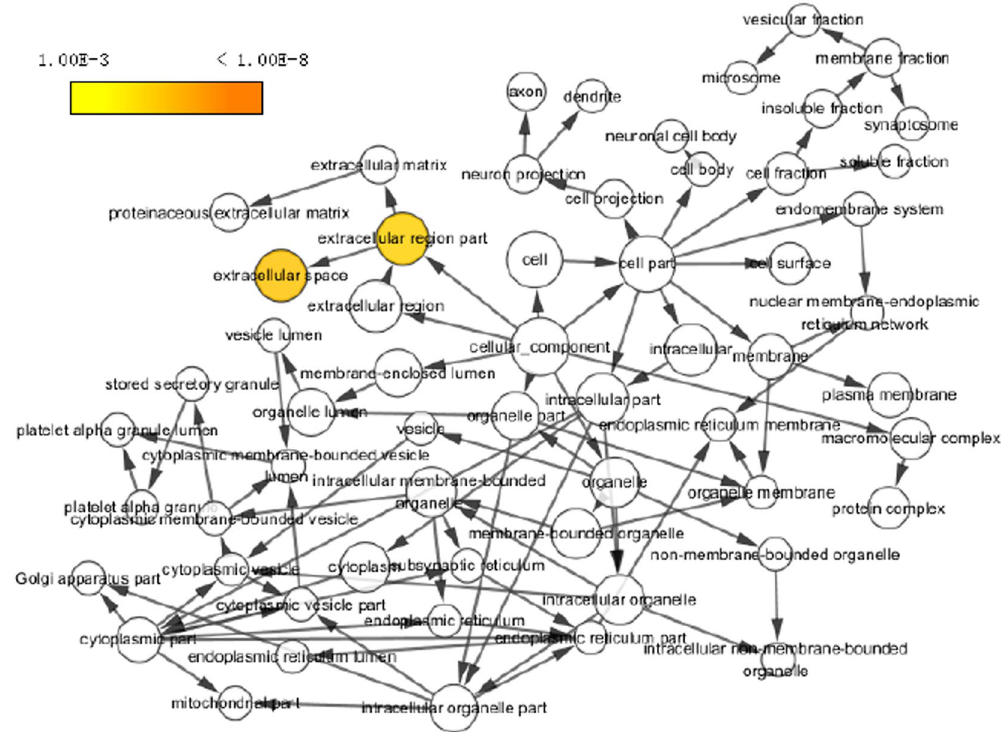
Figure 3. Hierarchical GO tree for cellular components enriched inGAS30. Considering a p-value of < 0.05, the circle sizes are proportional to the number of genes included in each. A dark color indicates a highly significant p-value and a high degree of enrichment. White circles represent